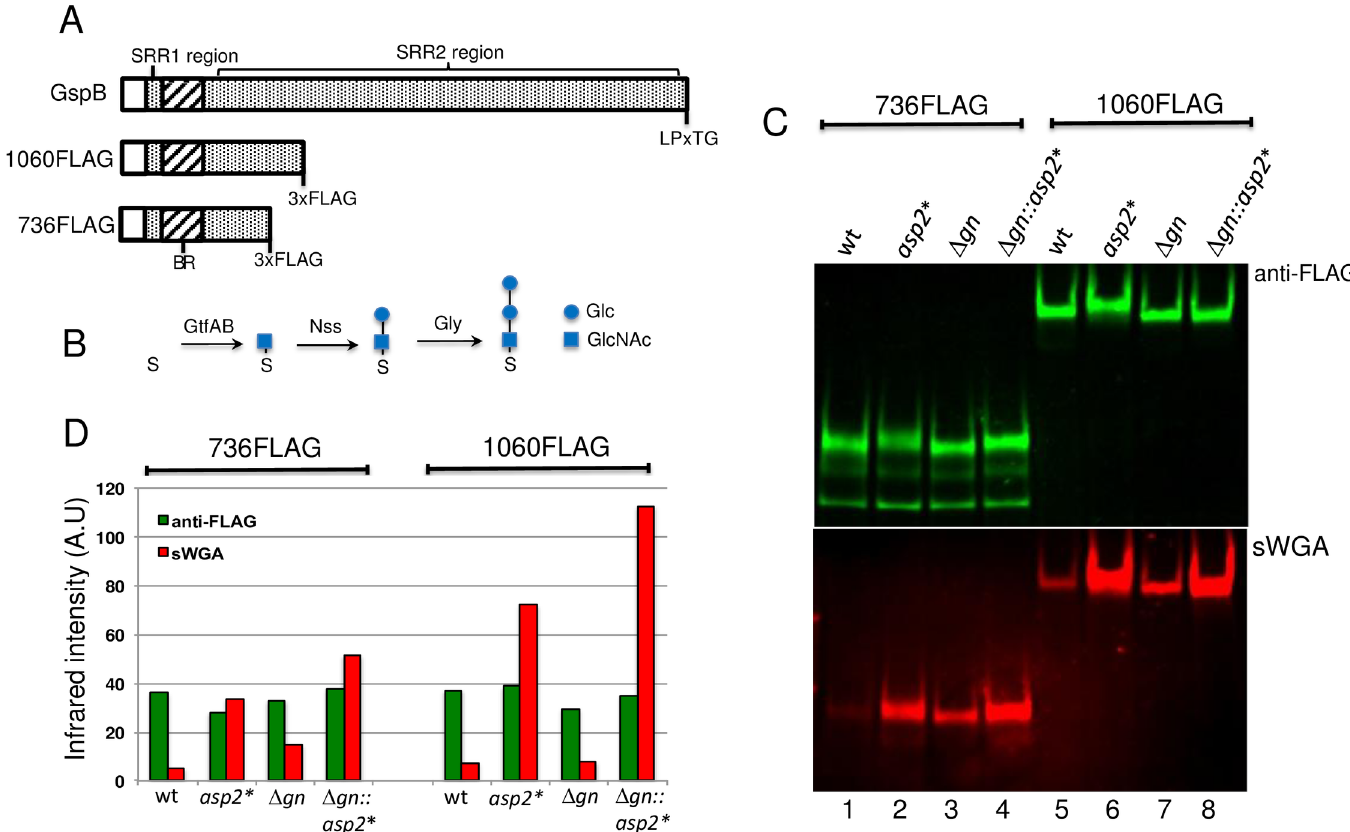
Fig 1. Reactivity of GlcNAc-modified GspB with sWGA. A) Schematic representation of wild-typeGspB, GspB1060flag and GspB736flag. The first and second glycosylatedserinerich repeat regions (SRR1 and SRR2) within GspB are shown together with the non-glycosylated substrate binding-region(BR). B) Schematic representation of GspB glycosylationby GtfAB, Nss and Gly. Glycan structures obtainedfrom MALDI-TOF profilingof SRR1 glycosylated by the designated Gtf (S1 Fig and S2 Fig) are shown. C) Western blot analysisof GspB736flag and GspB1060flag export by parentalstrains PS1225(lane 1) and PS921 (lane 5), their nss and gly deletionvariants ( Δ gn ) PS3309(lane 3) and PS3318(lane 7) and their correspondingderivative strains harboringthe S362A mutation within asp2 (asp2 * ) ,PS3539(lane 2), PS3540(lane 4), PS3541(lane 6), PS3542(lane 8). Culturemedia was collectedfrom exponentially growingstrains and proteins were separatedby SDS-PAGE and subjectedto Western blot analysisusing anti-FLAG antibodies and biotinylated sWGA to determineGspB levels and GlcNAc reactivity, respectively. D) Densitometry analysisof GspB736flagand GspB1060flag levels and GlcNAc reactivity. The y-axis represents GspB levels and GlcNAc reactivity basedon band intensity analysisvia LI-COR imaging. Western and lectin blot analysisof secreted GspB variants, together with correspondingdensitometry analysis, are representative results from 3 different genetictransformants.